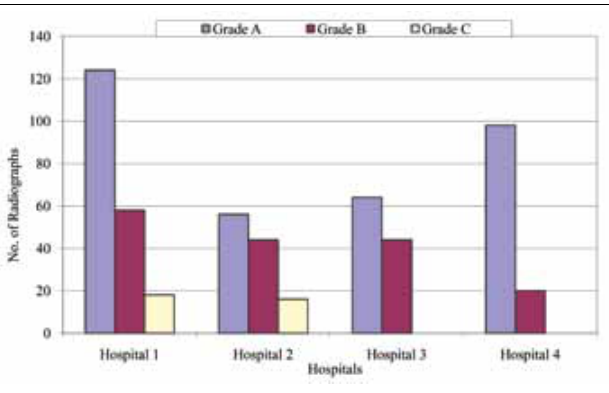
Fig. 4. Image quality performance per